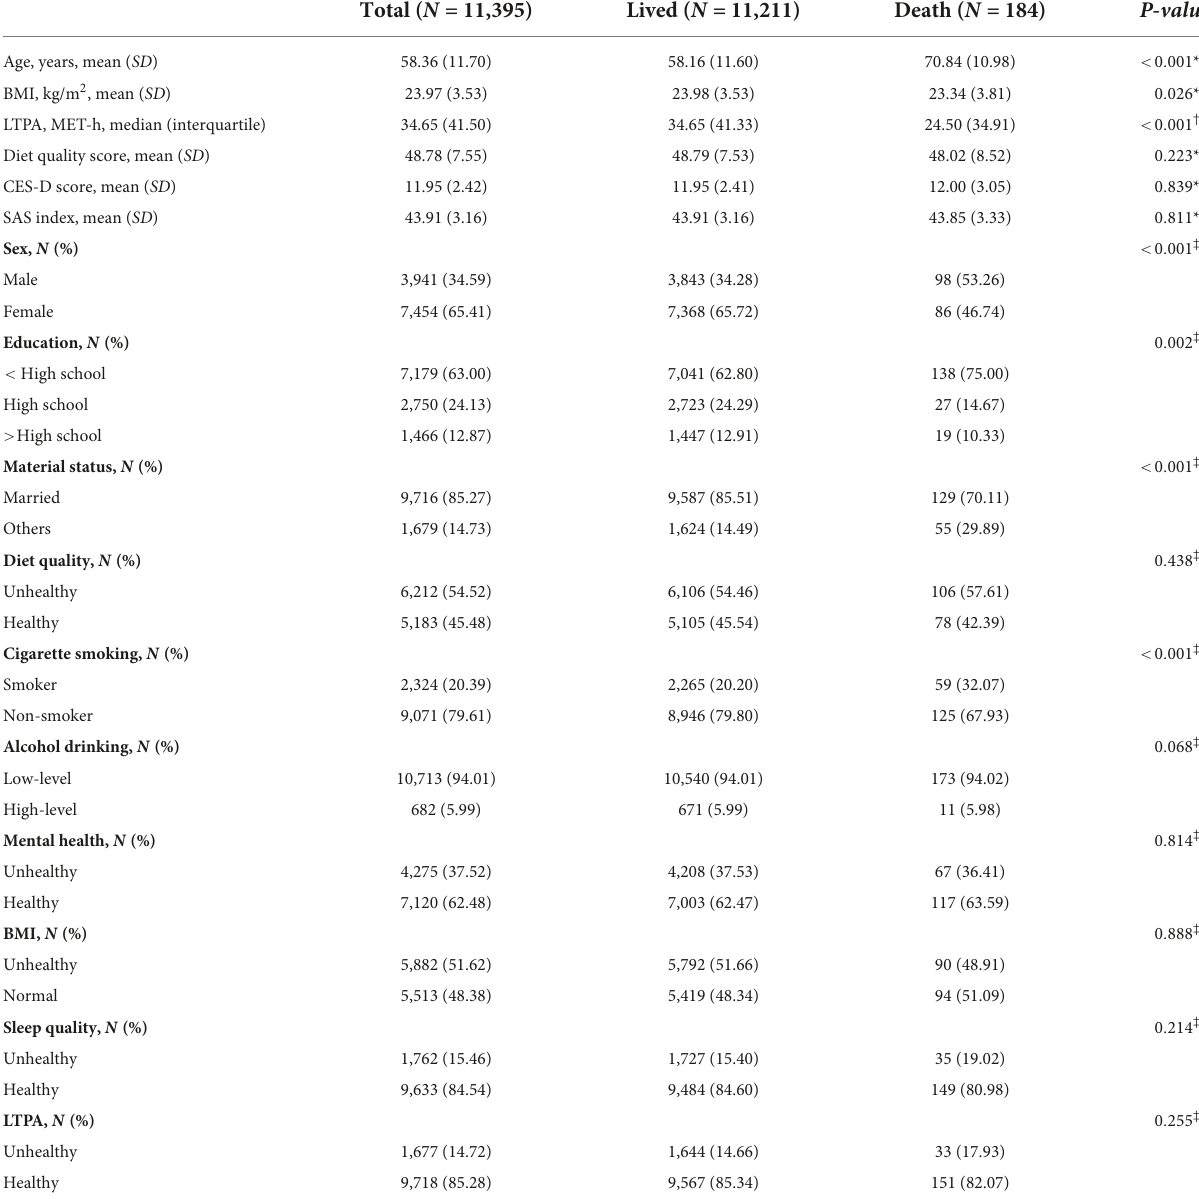
TABLE 2 The characteristics of